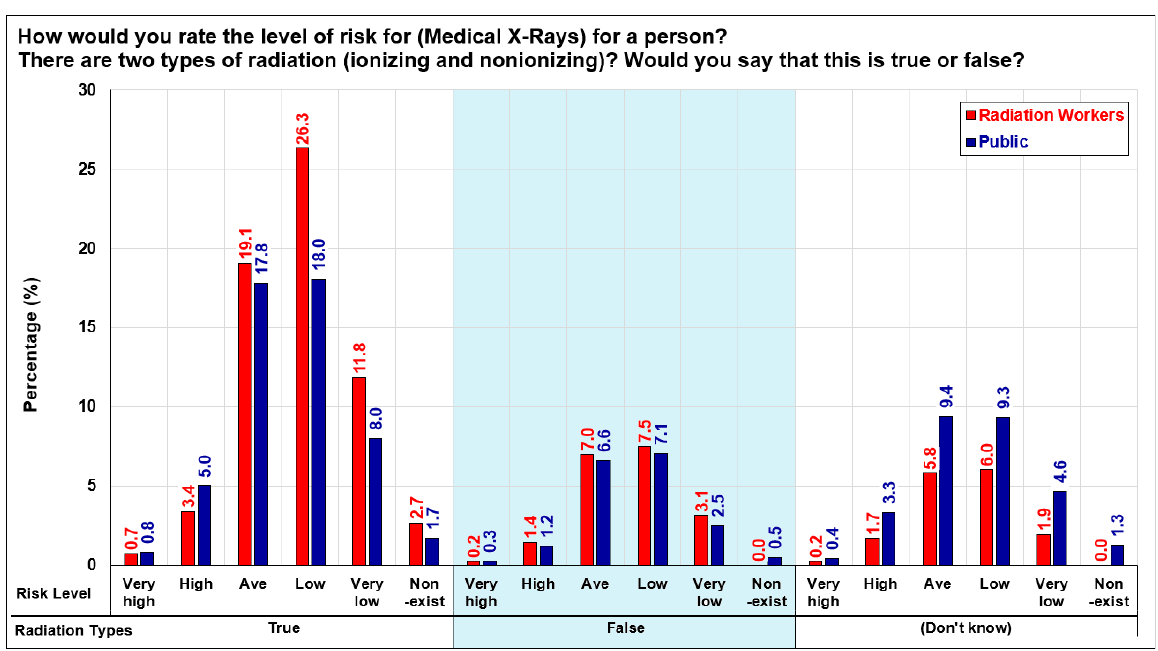
Figure 2. Radiation workers and public ranking of the level of risk for medical X-rays and correct answer regarding two types of radiation.